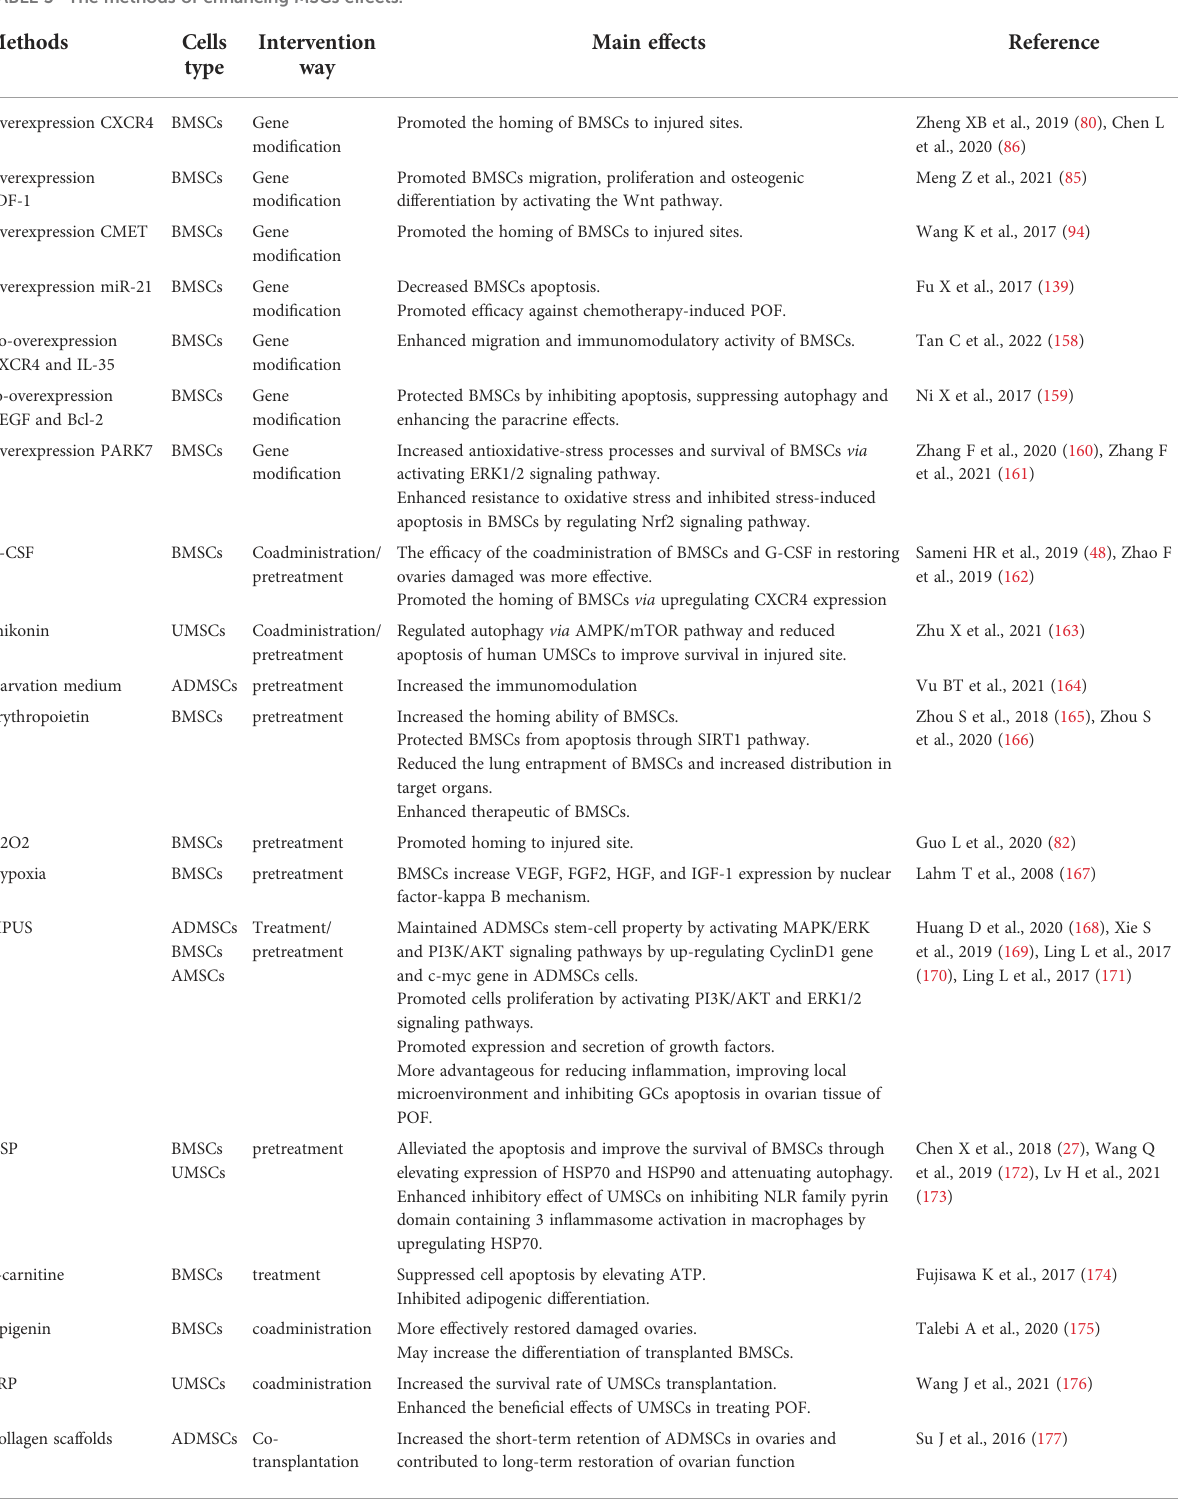
TABLE 3 The methods of enhancing MSCs